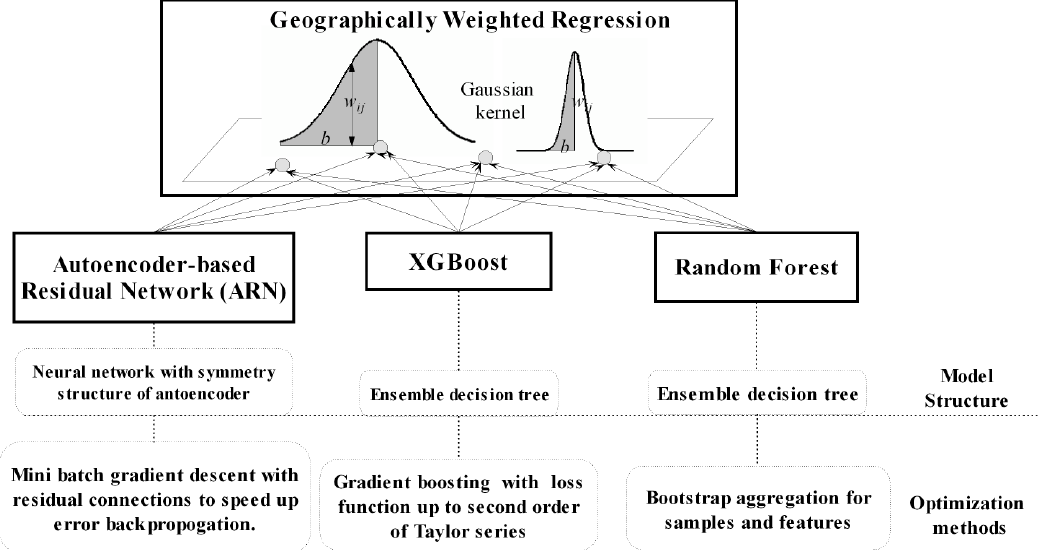
Figure 3. Geographically weighted ensemble machine learning.